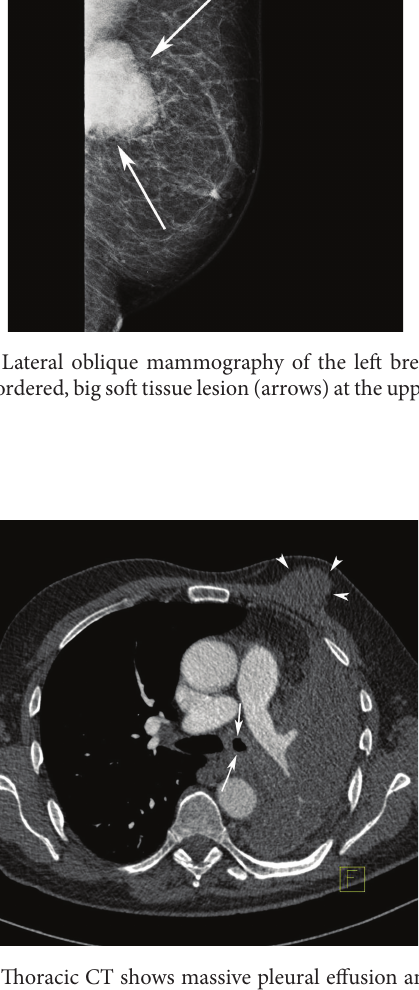
Figure 2: Thoracic CT shows massive pleural effusion and the left main bronchial obliteration (arrows) in the left lung. CT also shows the solid mass (arrowheads) in the left breast.